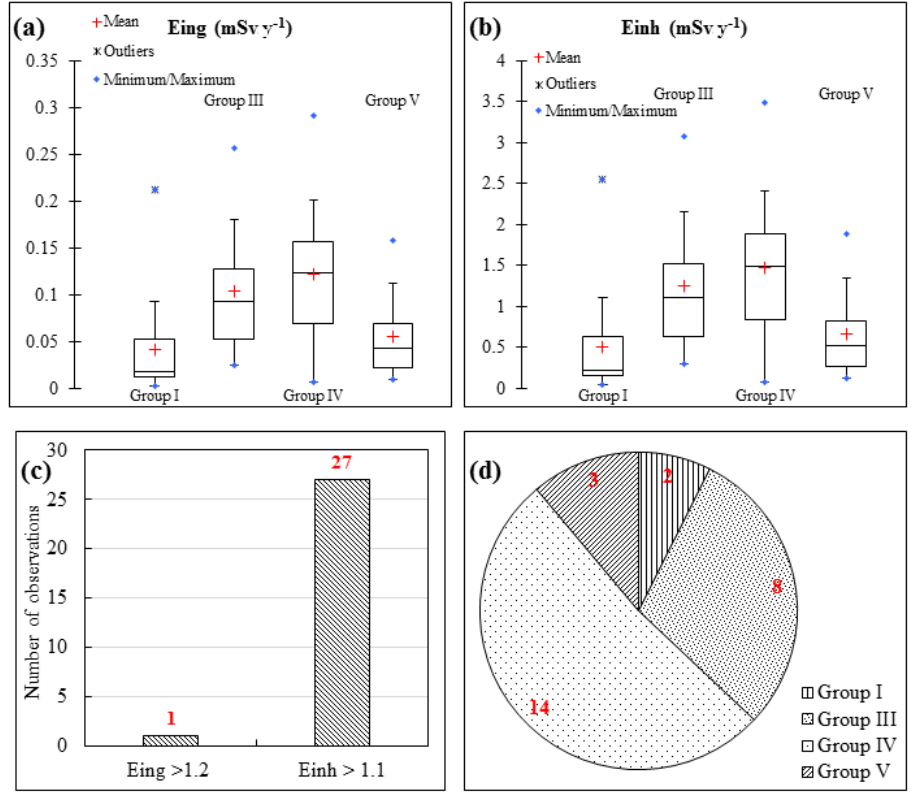
Figure 7. Evaluation of annual effective dose from drinking water consumption: ( a ) Annual effective dose from radon ingestion; ( b ) annual effective dose from radon inhalation; ( c ) number of observations for inhalation and ingestion effective dose above average worldwide; and ( d ) distribution of observations by groups from inhalation effective dose above the average worldwide.